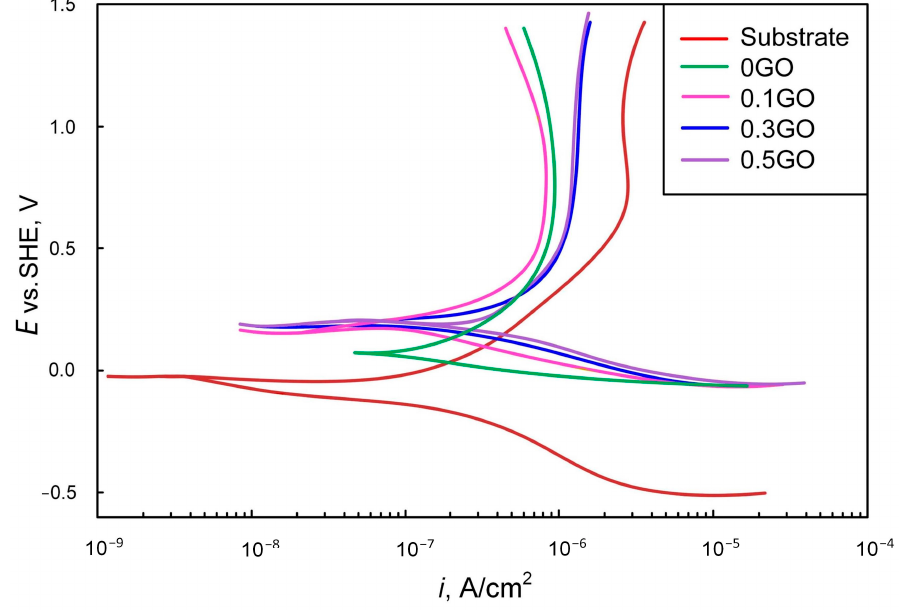
Figure 8. Potentiodynamic polarization curves after 30 min of immersion in corrosive solution of 3.5% NaCl at room temperature for all studied samples.